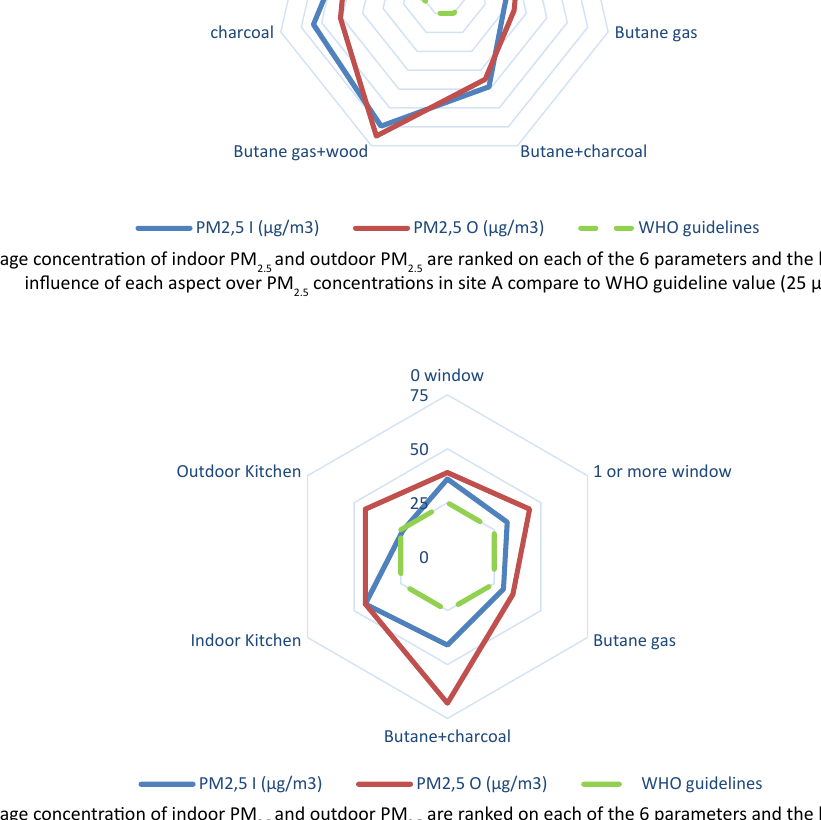
Fig. 3. Average concentration of indoor PM and outdoor PM are ranked on each of the 6 parameters and the line helps to visually 2.5 2.5 influence of each aspect over PM concentrations in site L compare to WHO guideline value (25 µg/m 3 2.5 Fig. 3: Average concentration of indoor PM 2.5 and outdoor PM 2.5 are ranked on each of the 6 parameters and the line helps to visually influence of each aspect over PM 2.5 concentrations in site L compare to WHO guideline value (25 µg/m 3 )